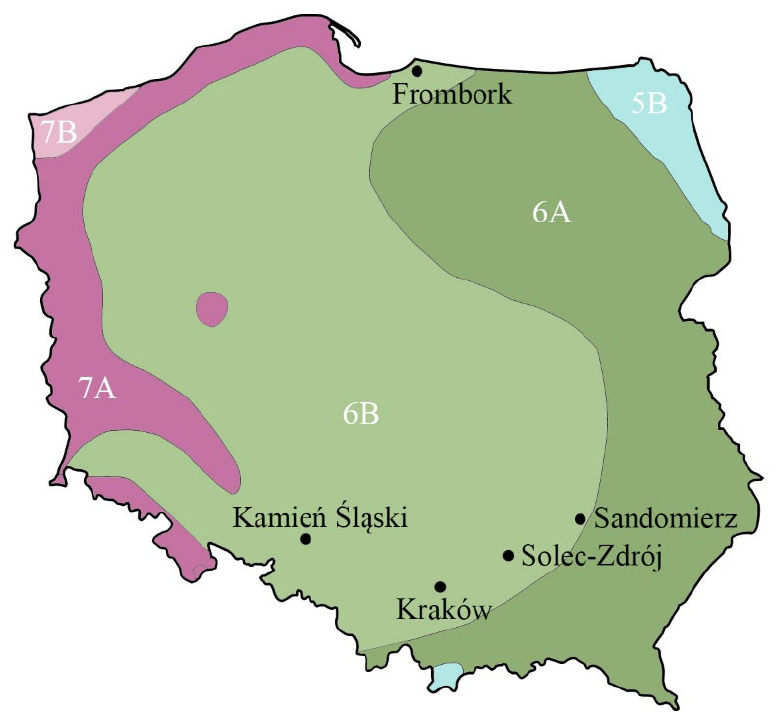
Figure 1. This illustration shows a map of Poland with the location of the herb gardens analyzed in this work. Colors and numbers with letters: 5B, 6A, 6B, 7A, 7B indicate frost zones of plants in Po